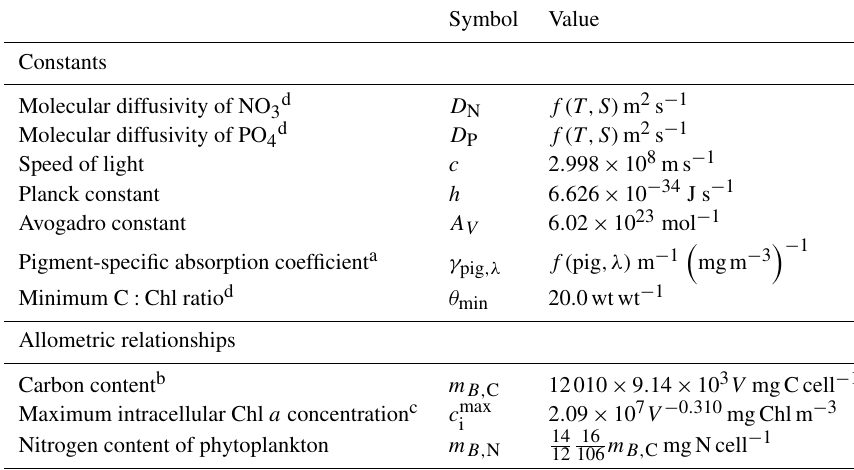
Table 6. Constants and parameter values used in the microalgae model. V is cell volume in µm 3 .